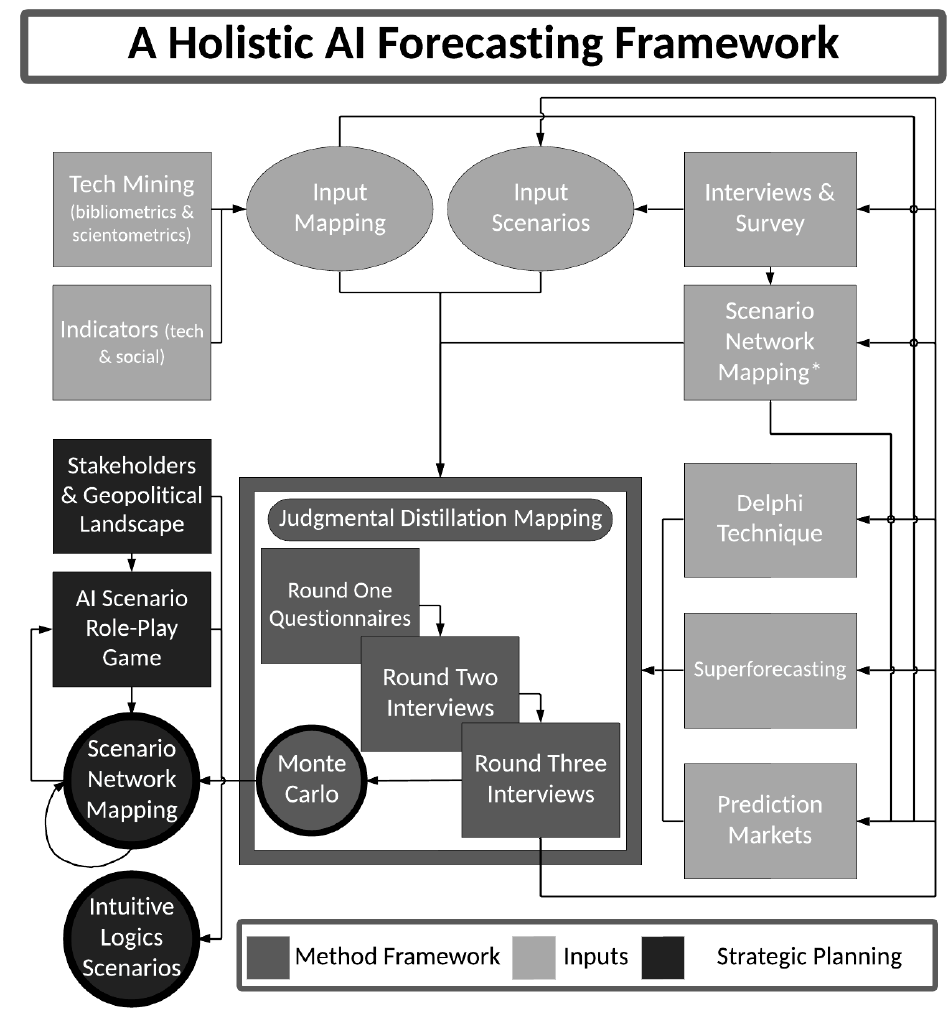
Figure 4. The proposed holistic framework for AI forecasting. Rectangular boxes denote inputs, ovals denote required inputs and circles denote actionable forecasts. Inputs to the framework must include scenarios and a mapping of indicators, however, the specific choice of these and the methods for obtaining them are flexible.